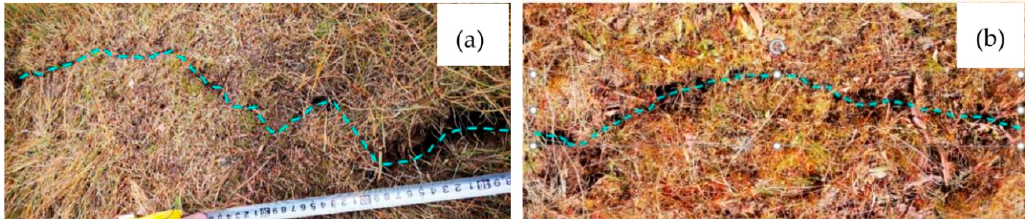
Figure 11. The planform crack pattern at the surface of the block in ( a ) AS and ( b ) AM.